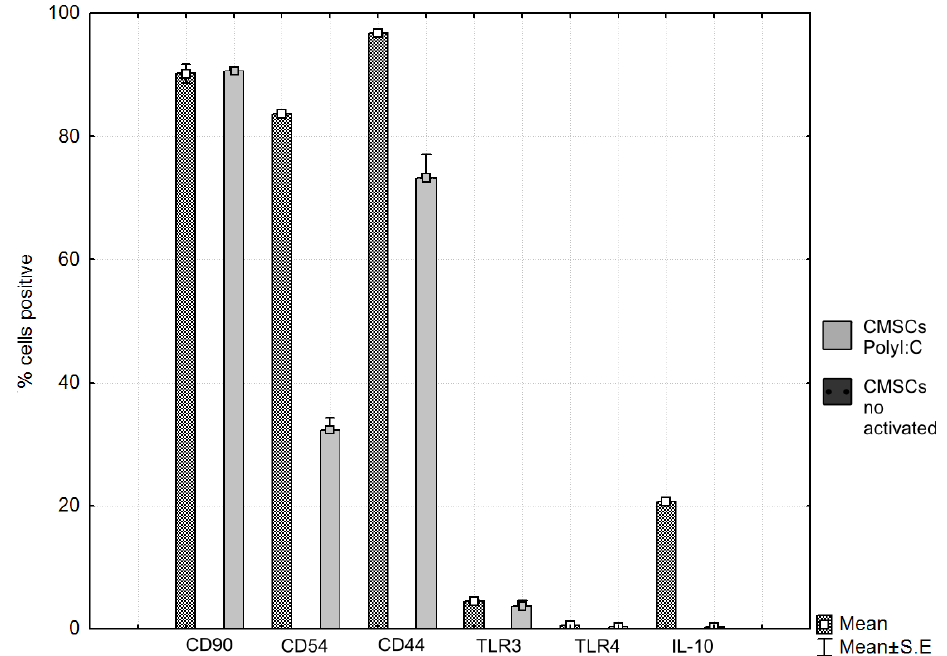
Figure 8. ( a ) Flow cytometry (FACS) analysis chorionic mesenchymal stem cells activated with polyinosine: polycytidylic acid CMSCs Poly (I:C) co-culture with lymphocyte and ( b ) FACS analysis CMSCs non-activated CMSCs co-culture with lymphocyte. Representative flow cytometry analysis.